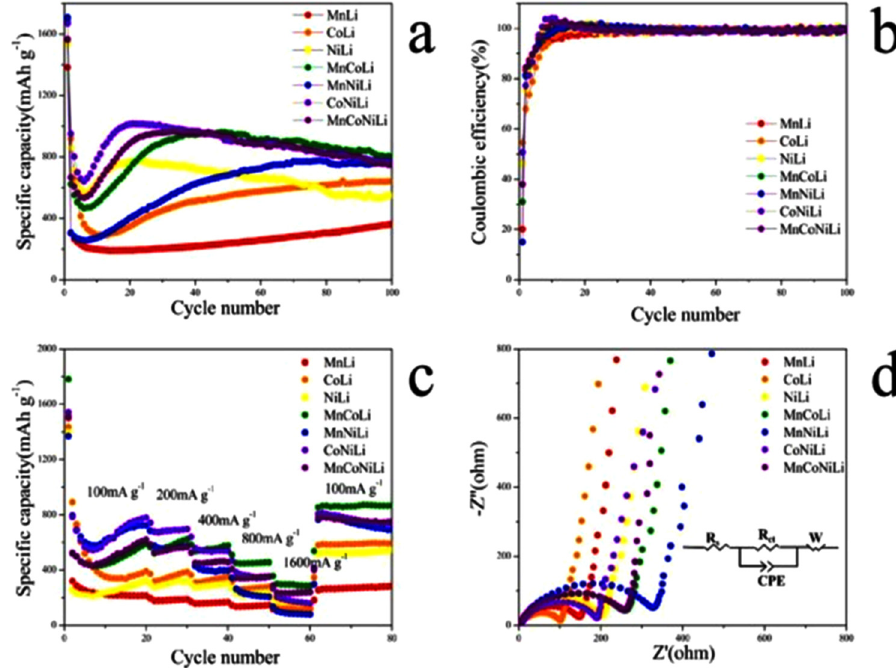
Figure 12. Electrochemical performance of MnLi, CoLi, NiLi, MnCoLi, MnNiLi, CoNiLi, and MnCoNiLi: ( a ) Cycling performance and ( b ) Coulombic efficiency of the electrodes at 0.1 A g − 1 ; ( c ) rate capabilities at various current densities; ( d ) EIS spectra of cells before cycling [68].Reproduced with permission.